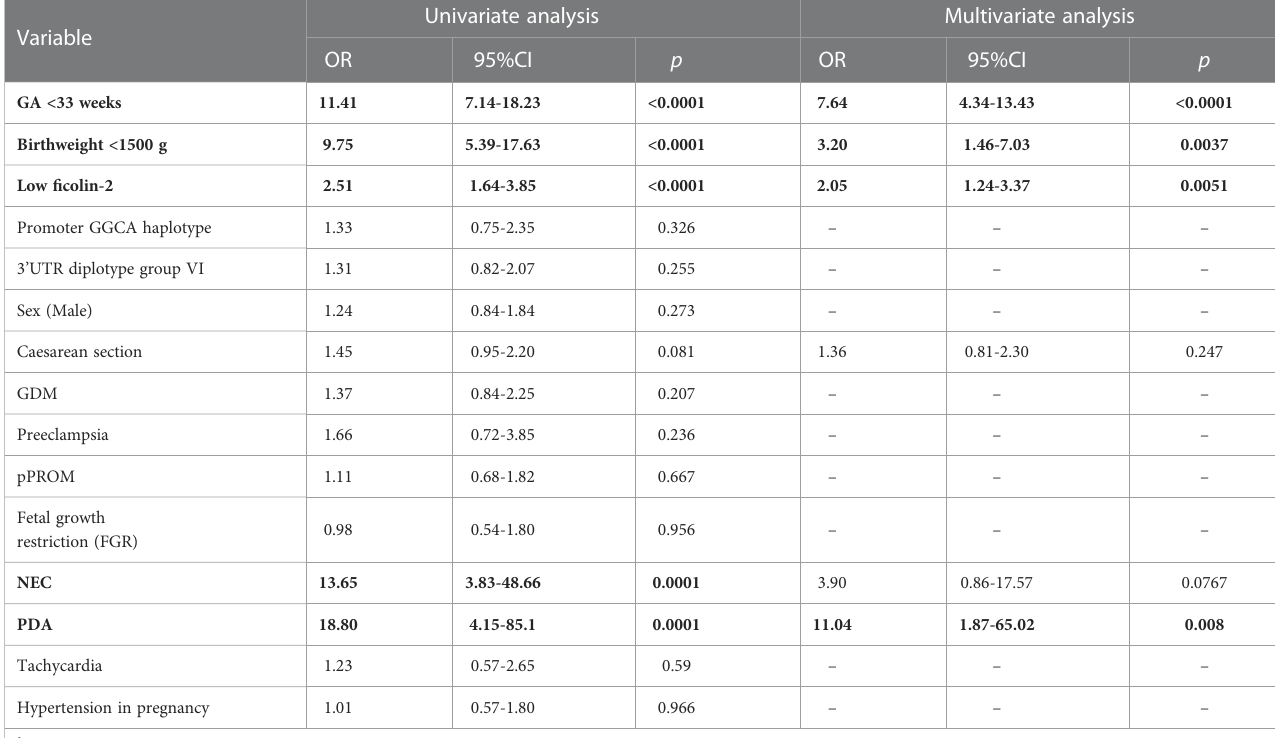
TABLE 3 Univariate and multivariate logistic regression analysis 1 of potential factors for RDS development.